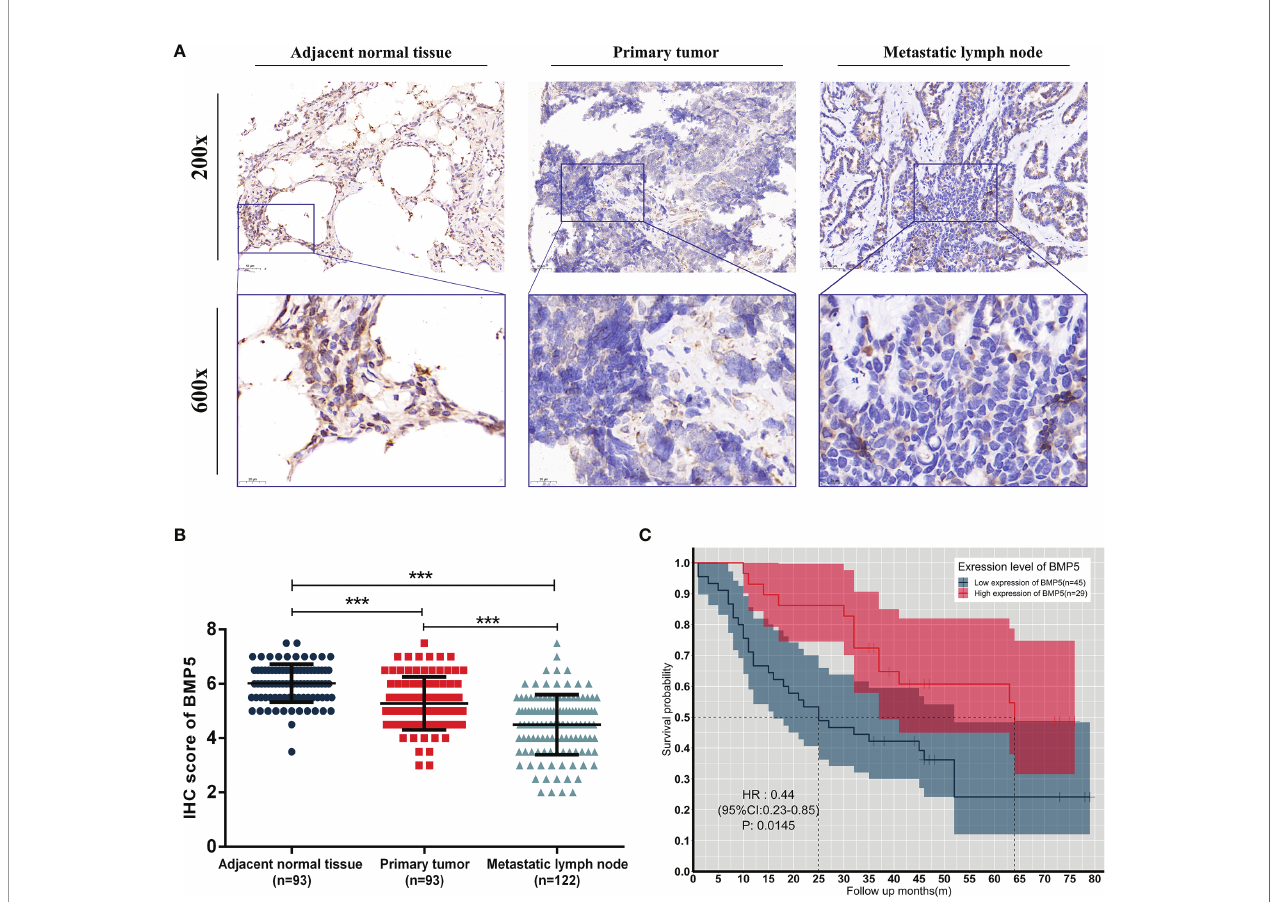
FIGURE 9 | Expression levels and prognosis values of BMP5 protein in patients with lung adenocarcinoma. (A) Representative IHC staining of BMP5 in sections from adjacent normal tissues, primary tumors, and metastatic lymph nodes. (B) The IHC score of METTL3 in adjacent normal tissues was higher than that of primary tumors and metastatic lymph nodes. Statistical signi fi cance was determined by a two-tailed, paired Student ’ s t -test. (C) Kaplan – Meier analysis of overall survival according to high and low BMP5 protein expression in 93 lung cancer patients (*** p <